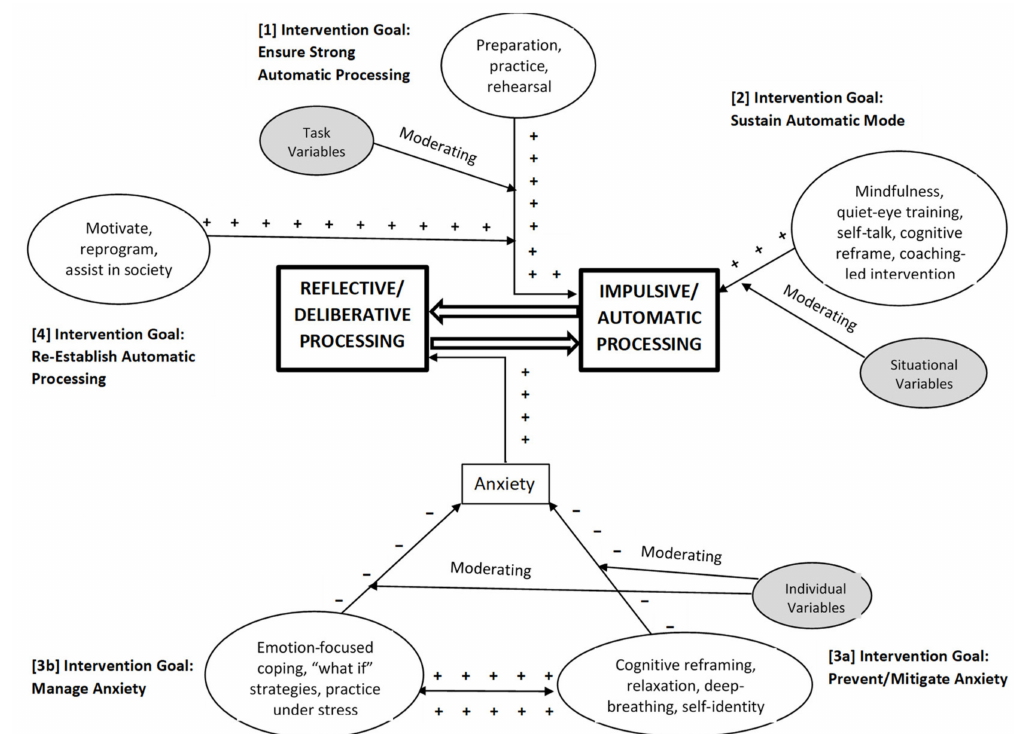
Figure 2. Scheme showing location of effect within RIM for the four intervention strategies (1,2,3a,3b,4) outlined in the text. Legend. ( a ) The two types of information processing are represented by the bold rectangles, with anxiety, represented by a smaller light rectangle, being a major source for retrogression to deliberative processing. ( b ) Intervention strategies (1, 2, 3a, 3b, and 4) are represented in bold font and corresponding ovals. ( c ) Moderating variables (task, situational, individual) are represented by the three shaded circles. ( d ) Signs (+ or − ) represent facilitative/additive or inhibitory